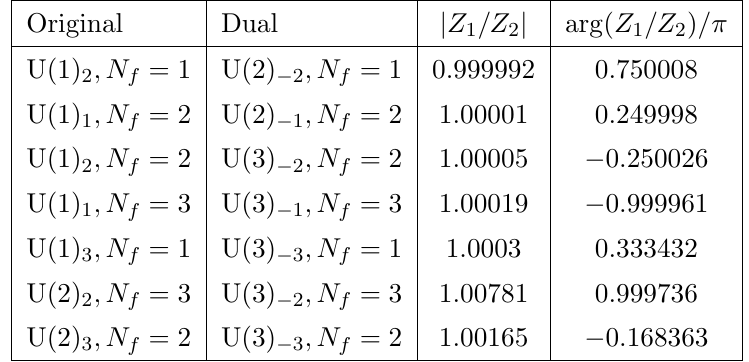
Table 2 . Results of numerical integration of the matrix model expression for the partition functions of several di(cid:11)erent Chern-Simons matter